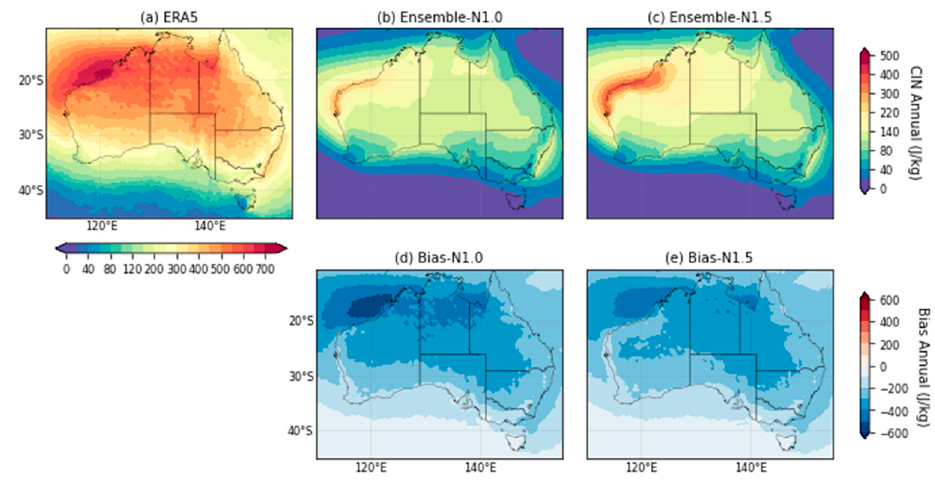
Figure 3. Climatology of the annual CIN in d01 from ( a ) ERA5, ( b ) N1.0 and ( c ) N1.5. ( d , e ) are the biases of N1.0 and N1.5 from ERA5, respectively. Unit: J kg − 1 .